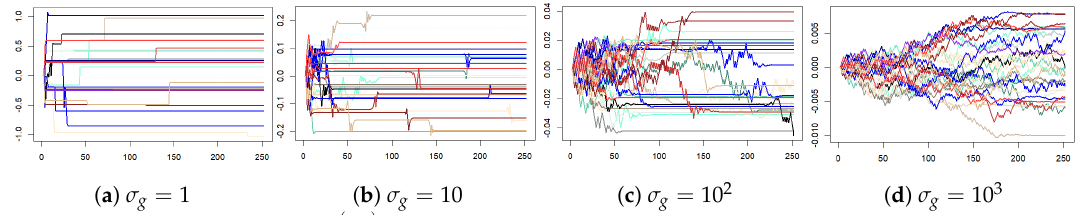
Figure A2. Computation of V Gaussian function g () employed here.